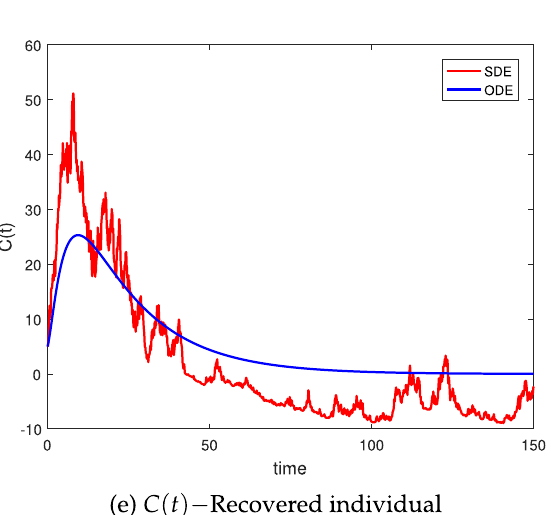
Figure 2. Simulations of ( H ( t ), V ( t ), U ( t ), A ( t ), C ( t )), for the stochastic models (1) with its corresponding deterministic